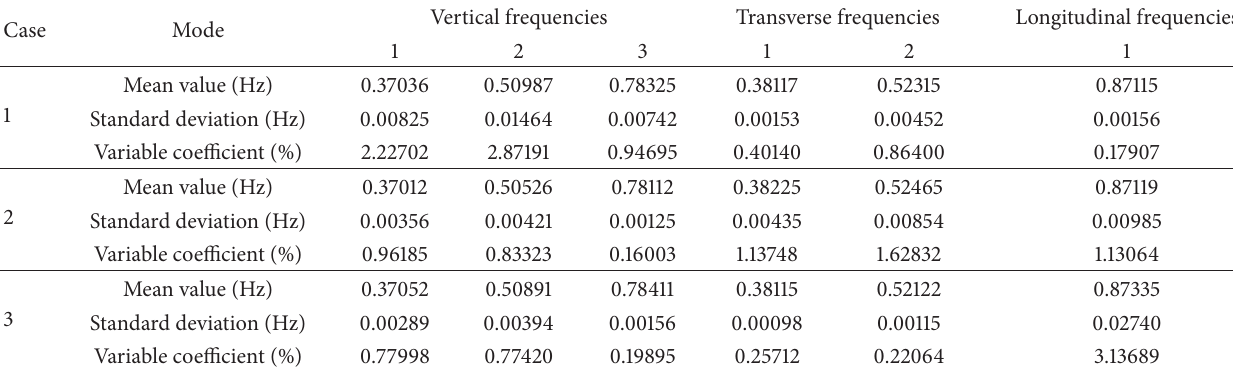
Table 13: The statistics of the frequencies in different conditions.